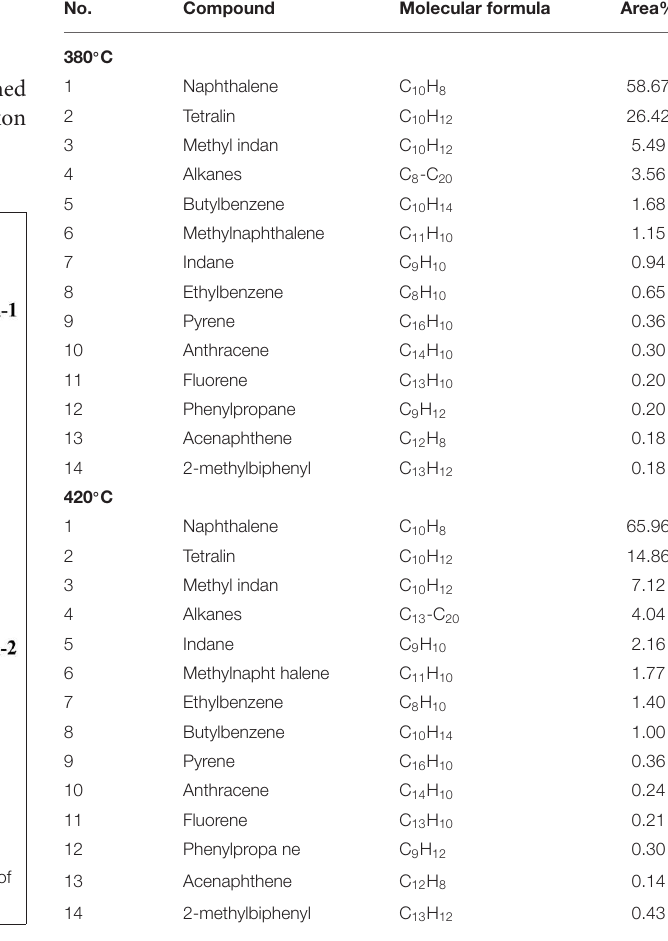
TABLE 5 | Relative content of hydrocarbons in